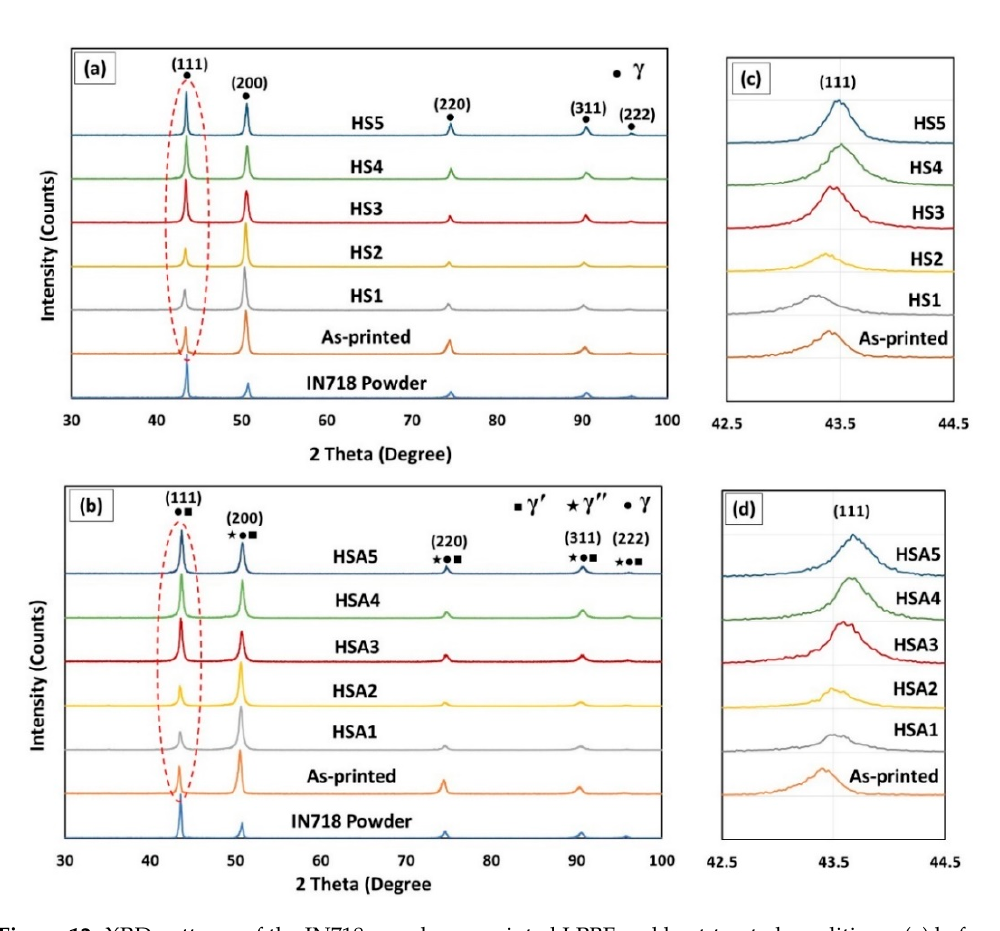
Figure 12. XRD patterns of the IN718 powder, as-printed LPBF and heat-treated conditions: ( a ) before aging; ( b ) after aging; ( c , d ) focus on 2 θ = 43.3 in both ( a , b ).